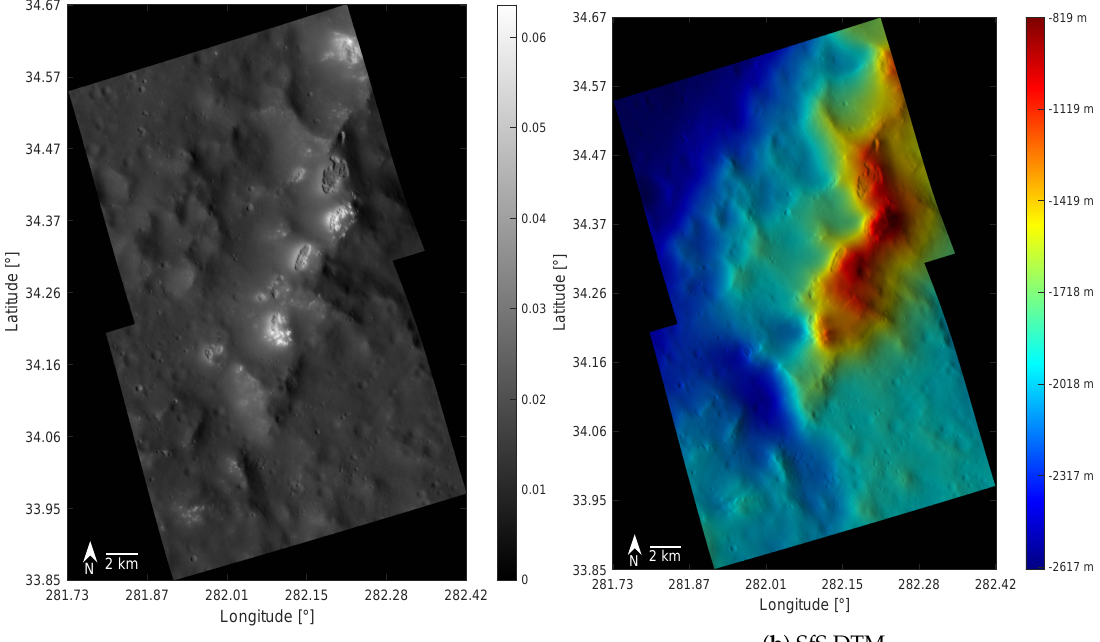
Figure 20. ( a ) Mosaic from the NAC images EN0213851669M and EN0213851674M at a resolution of 15.3m/Pixel. This section of the inner ring of the Aksakov crater shows different stages of the formation of hollows. ( b ) Color-coded SfS